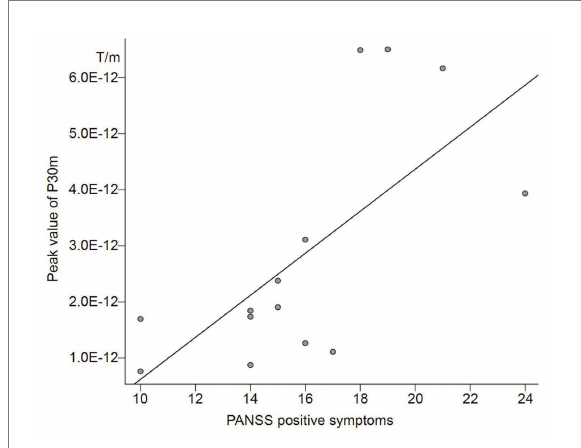
FIGURE 2 Correlation between PANSS positive symptom score and peak value of P30m in patients with